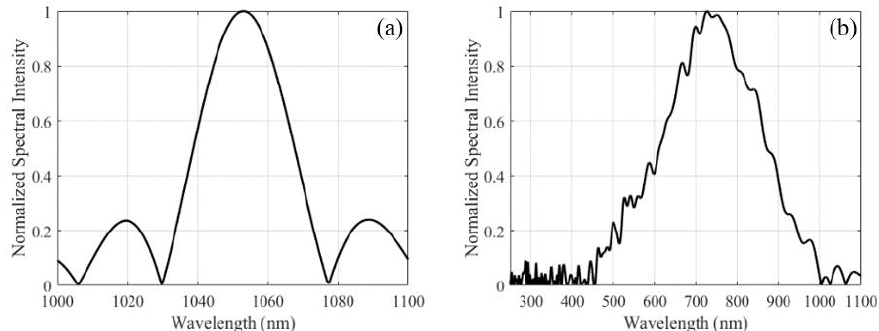
Figure 7. Recovery spectra of ( a ) 1053 nm and ( b ) halogen light.